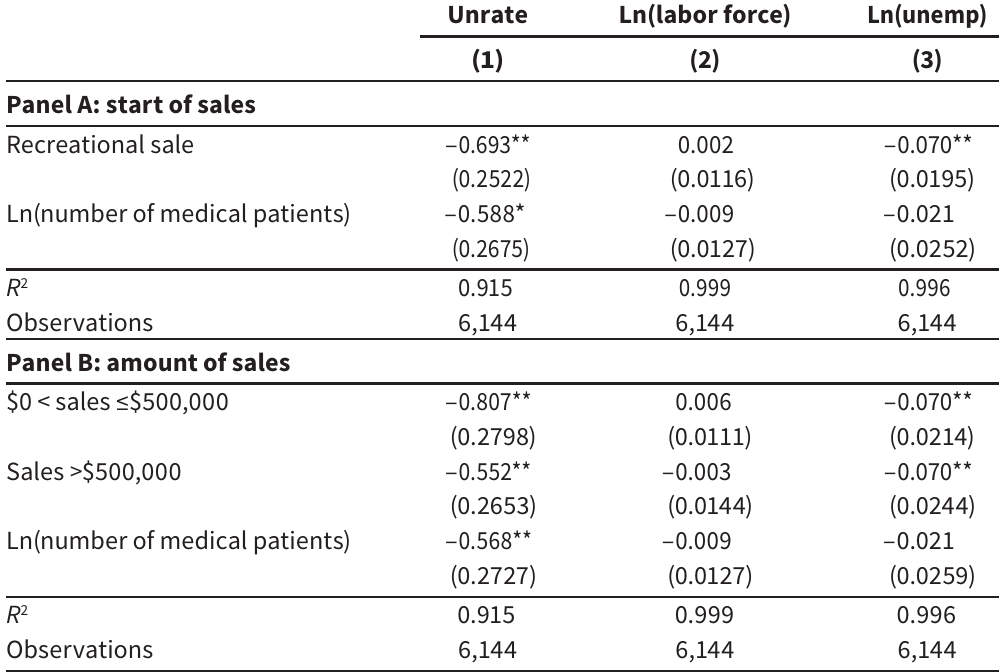
The effect of recreational dispensary entry and sales on the